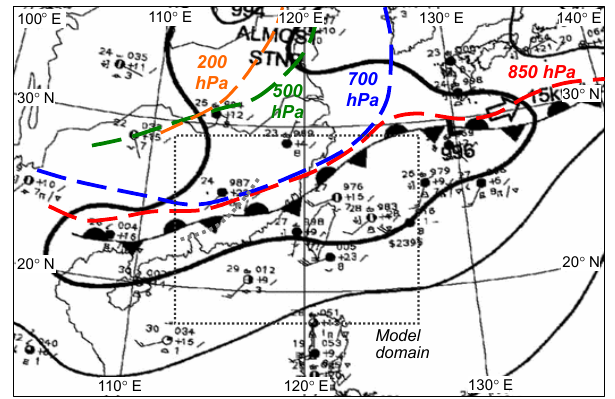
Figure 1. CWB surface analyses and positions of front/trough (or wind-shift line, thick dashed) at 850 (red), 700 (blue), 500 (green), and 200hPa (orange) at 12:00UTC on 11 June 2012. The CReSS model domain is marked by the dotted